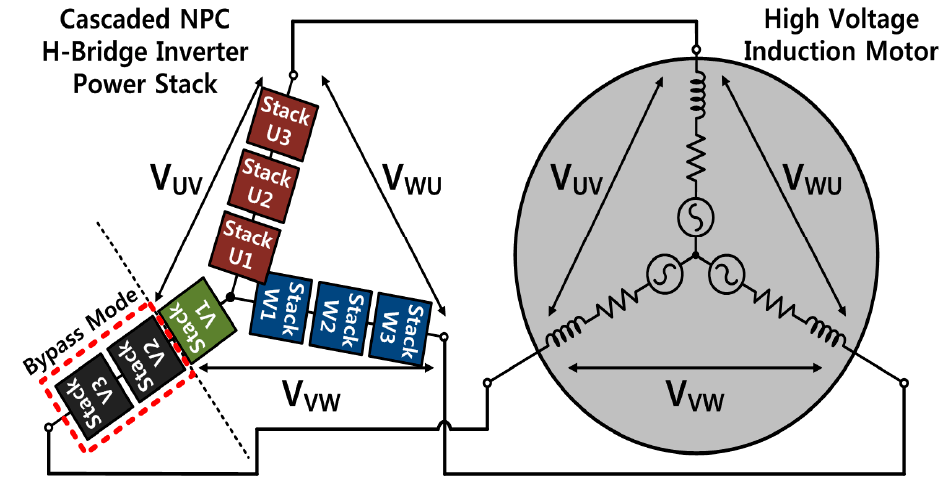
Figure 2. Neutral-point voltage-shifting control for high-voltage induction motor in failure situation of stack V2 and V3.